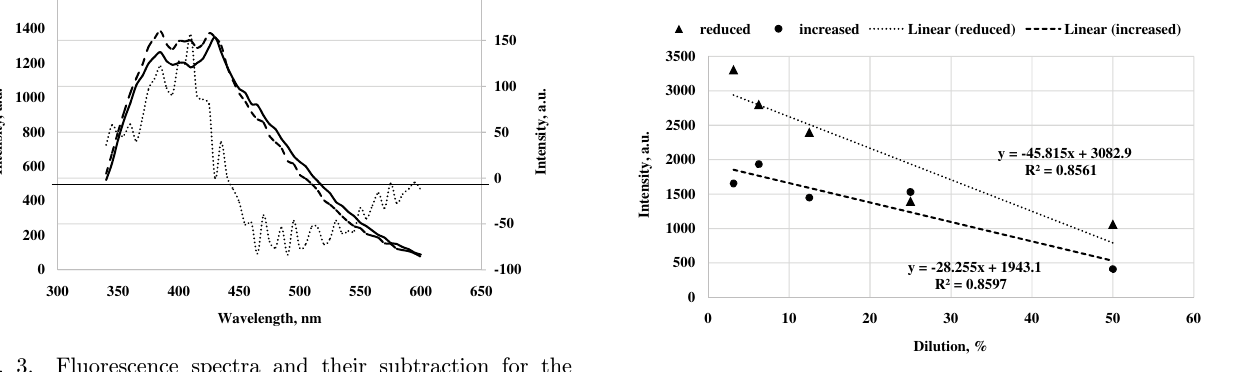
Fig. 4. Reduced (triangles) and increased (circles) light sums as the result of a CKD Pt's serum dilution to the levels of residual VFS given in